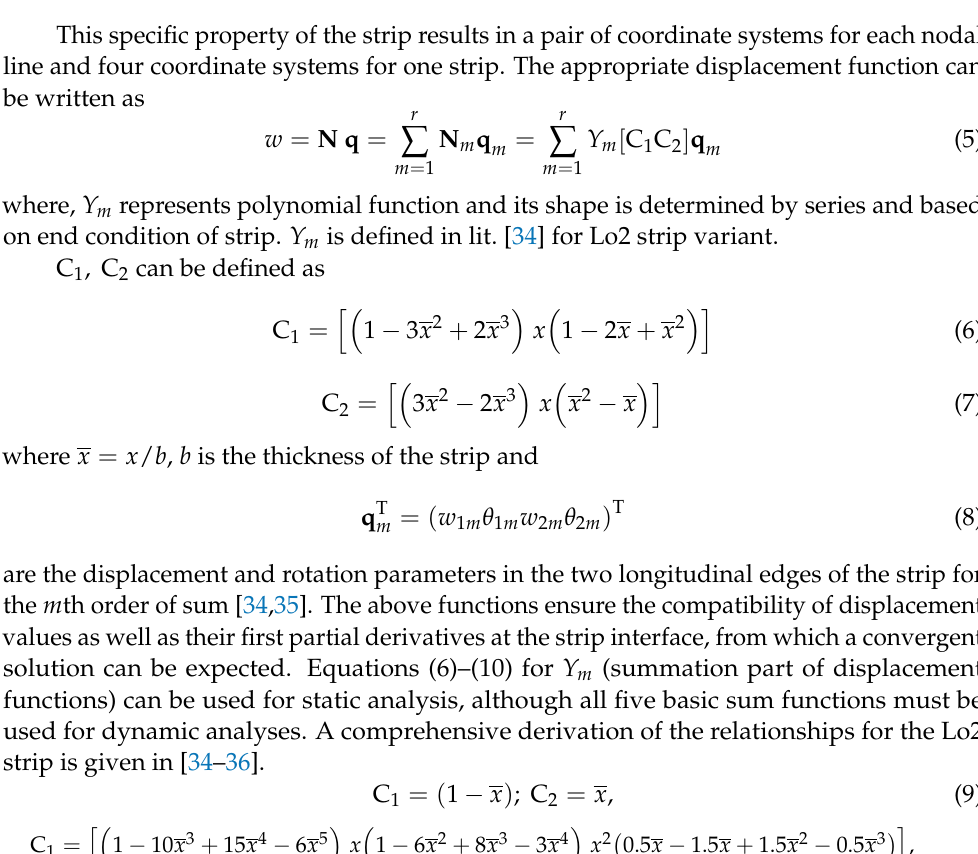
Figure 8. Finite strip Lo2 variant.